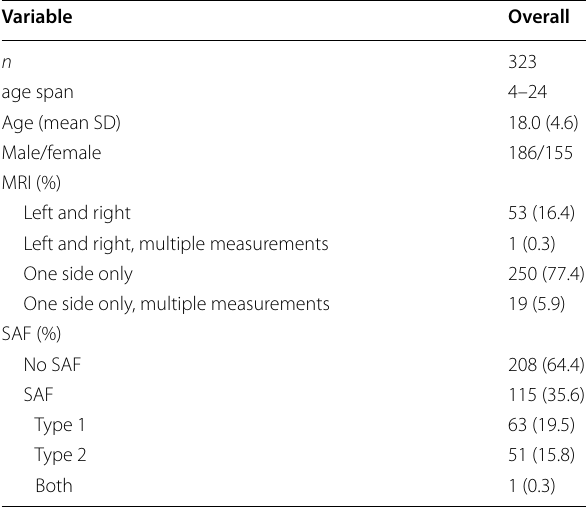
Table 2 Key demographics, MRI-studies and findings